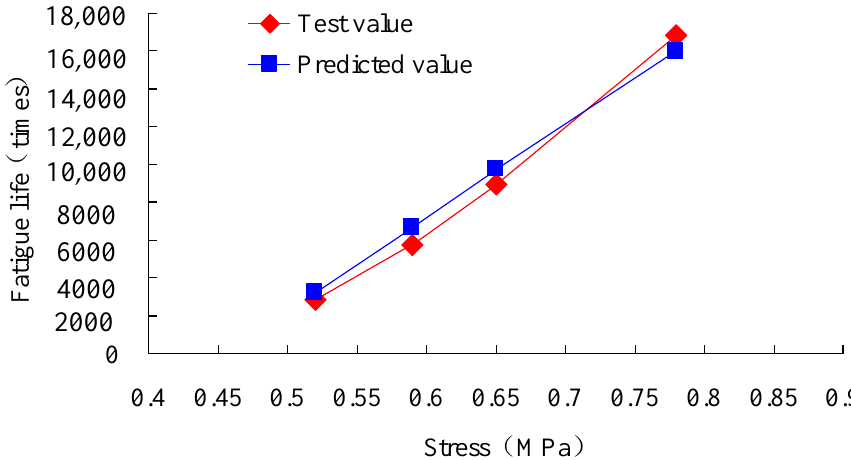
Figure 7. Beam samples for four point bending fatigue test.